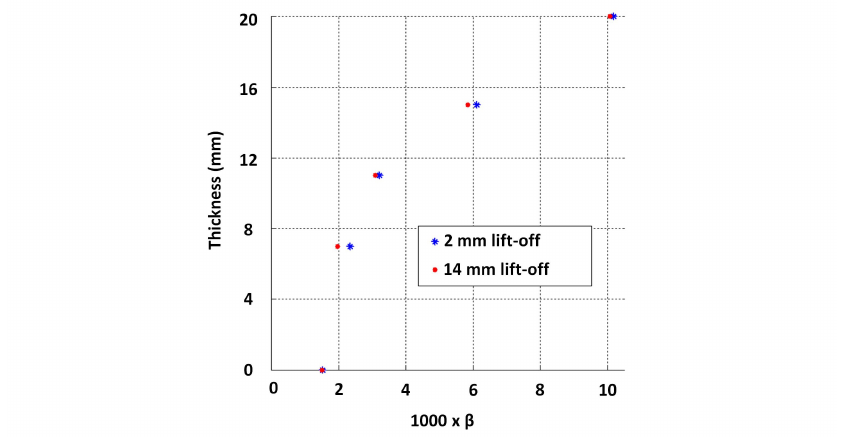
Figure 16. Influence of lift-off on the function between thickness and β .